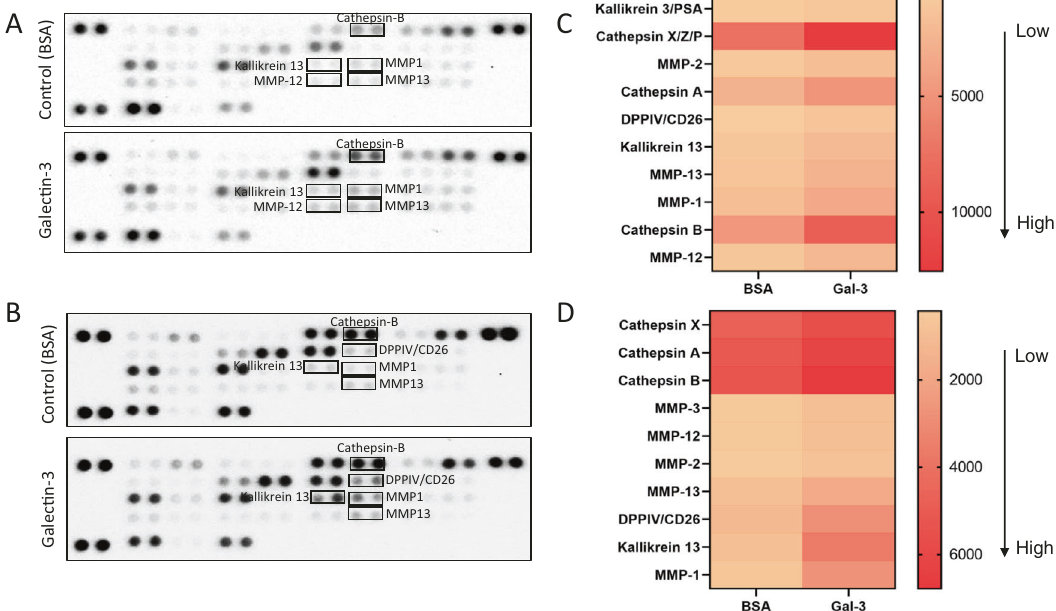
Fig. 1 Galectin-3 induces the secretion of a number of proteases in human colon cancer cells. SW620 ( A ) and HCT116 ( B ) cells were treated with 10 µg/ml galectin-3 or BSA for 24 h before the levels of 35 proteases were analysed by Proteome Pro fi ler Human Protease Array. The ten most changed proteases by the cells in response to galectin-3 are shown in heatmaps in ( C ) (SW620) and D (HCT116) (with changes ranked from lowest to